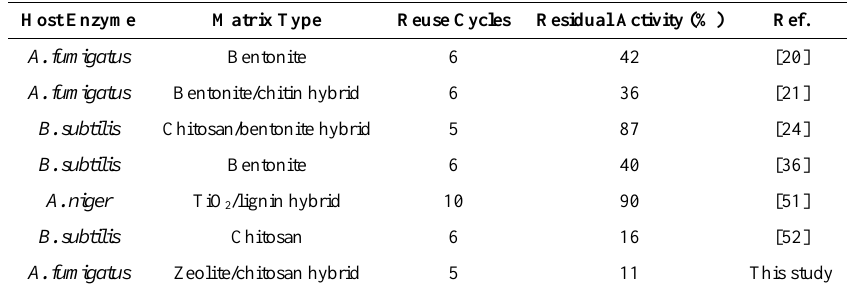
Table 4. Reusability study for immobilized α-amylase in the latest